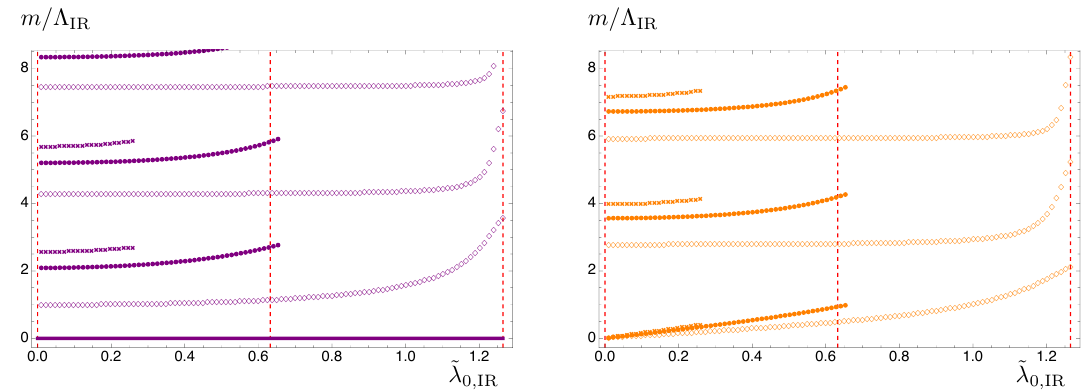
Figure 17 . AdS background. Fermionic spectrum as a function of ˜ λ 0 , IR for ∆ R = 1 . 7 , 2 . 3 , 2 . 6 (diamonds, dots, crosses). The corresponding IR fixed point values ( ˜ λ 0 = and ˜ λ 0 = 0 when ∆ R ≥ 2 . 5 ) are indicated by vertical dashed lines. The left and right panels correspond to imposing (+) and ( − ) IR boundary conditions, respectively. The solid line in the left panel indicates the presence of a massless state. The ratio between the UV and IR energy scales is equal to Λ UV = 10 3 . Λ IR